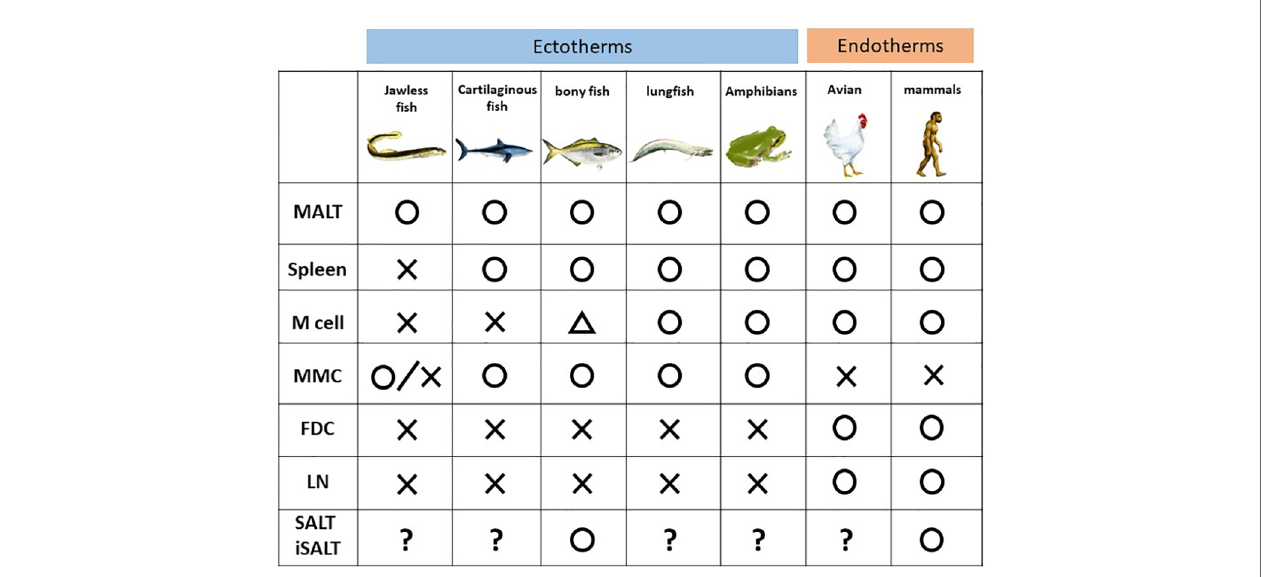
FIGURE 2 | Phylogenic comparison of immune components among the vertebrates. MALT, mucosa-associated lymphoid cells; MMC, melanomacrophage center; FDC, follicular dendritic cells; LN, lymph node and its counterpart; SALT, skin-associated lymphoid cells; iSALT, inducible